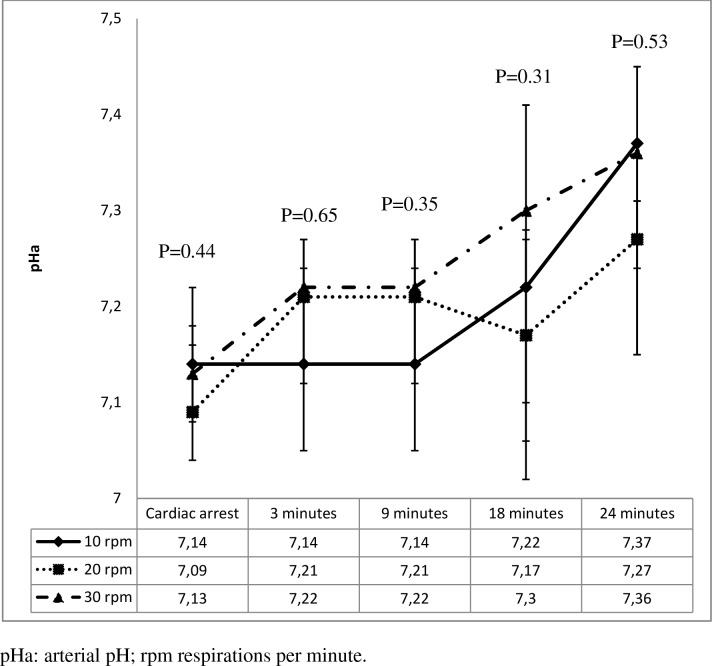
Arterial pH values during resuscitation.